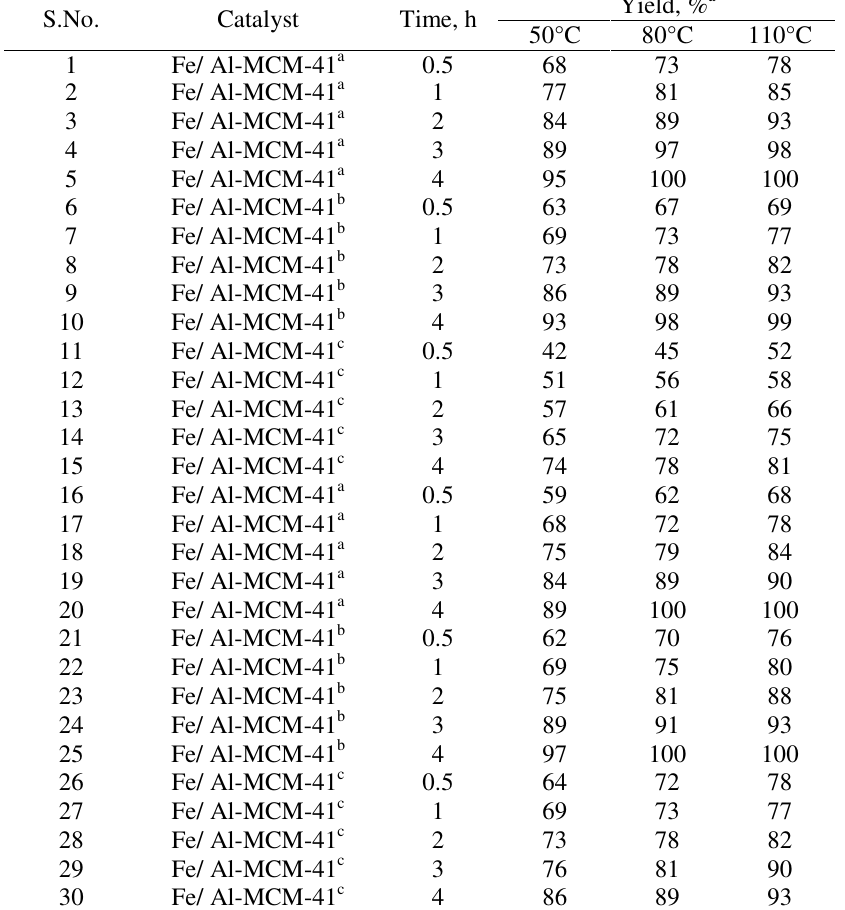
Table 2. Effect of temperature on the % yield of dibenzyl derivatives over various iron loaded